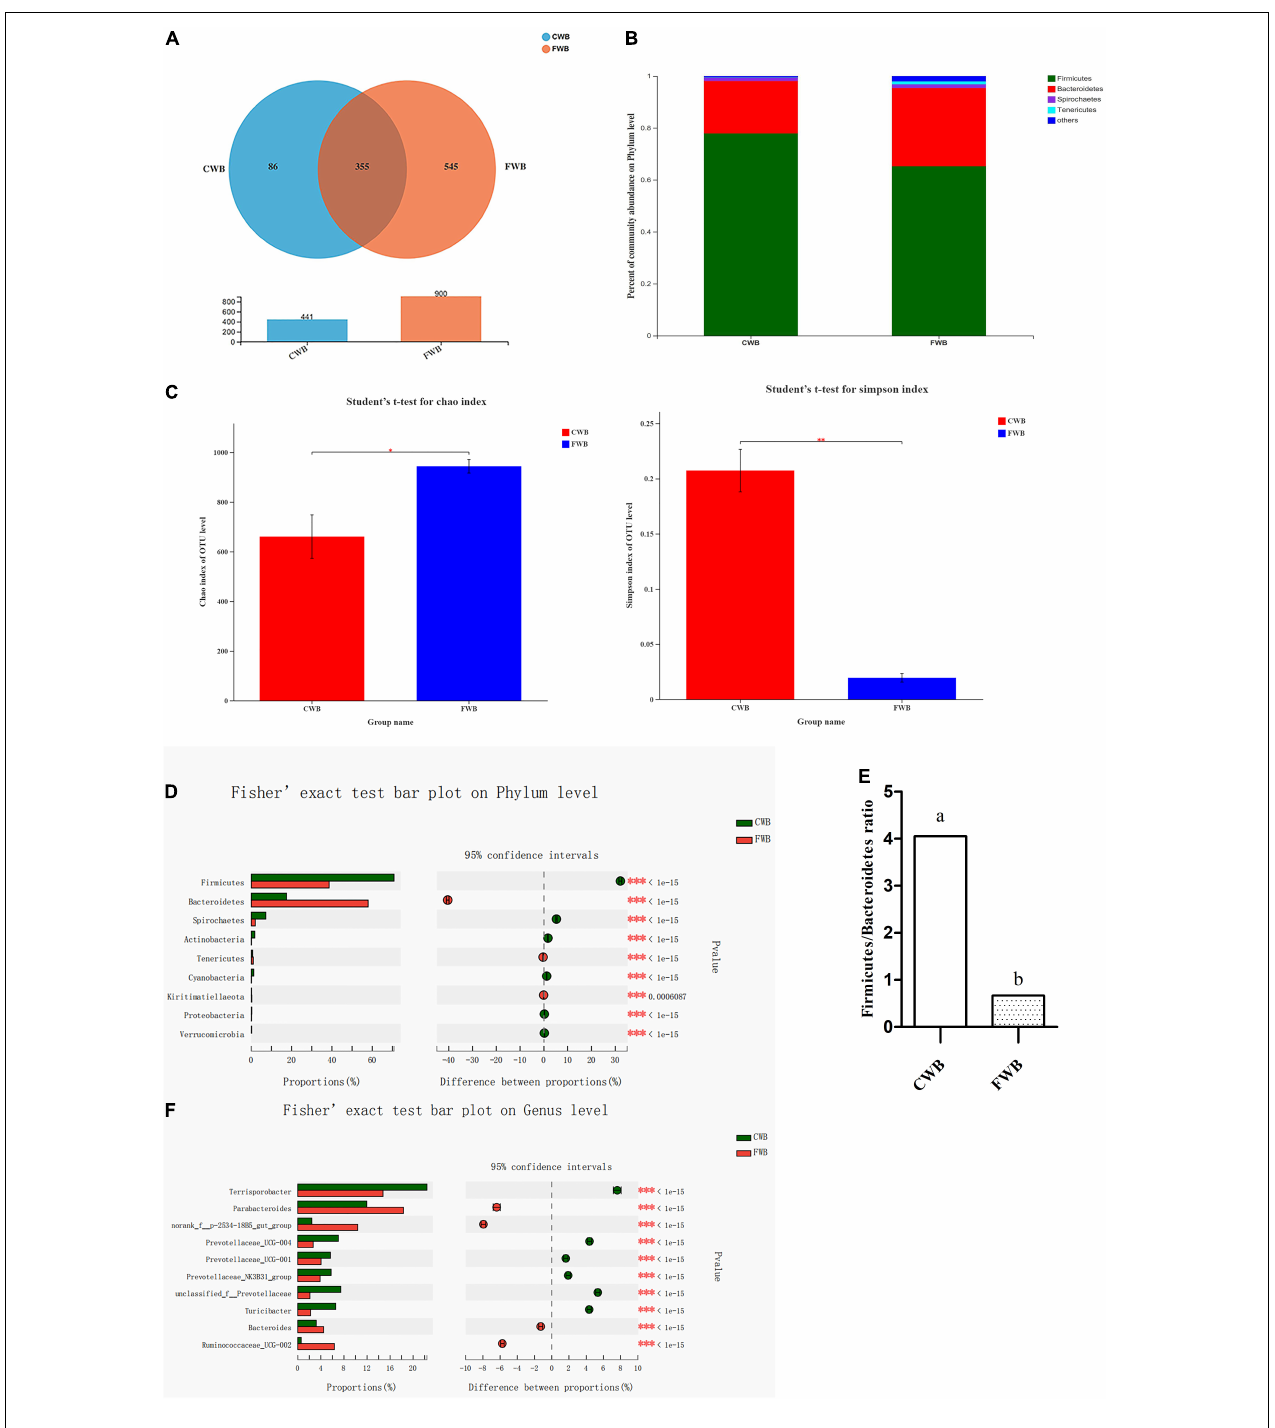
FIGURE 4 | Effects of different particle sizes of wheat bran on maternal gut microbiota during gestation. (A) OTU Venn of two dietary treatments. (B) Percent of community abundance on phylum level; the results were analyzed by Student’s t -test and presented as mean values of different bacteria, n = 6. (C) The Chao index of bacterial community, p = 0.04; the Simpson index of bacterial community, p = 0.03. (D) The difference of microbiota on phylum level; the results analyzed by Fisher’s exact test, n = 6. (E) The ratio of Firmicutes to Bacteroidetes , the result presented as mean values. a , b Means without common letters differ at p < 0.05. (F) The difference of microbiota on genus level, the results analyzed by Fisher’s exact test, n = 6; the y -axis represents the microbiota name at a certain classification level, and each column corresponding to the microbiota represents the relative abundance of the microbiota in each sample; the middle area is the set confidence interval, and the value corresponding to the circle point represents the relative abundance difference of the microbiota in the sample; the rightmost is p -value, ∗ 0.01 < p ≤ 0.05, ∗∗ 0.001 < p ≤ 0.01, ∗∗∗ p ≤ 0.001; CWB, a diet containing coarse wheat bran, with particle size of 605 µ m; FWB, a diet containing fine wheat bran, with particle size of 438 µ